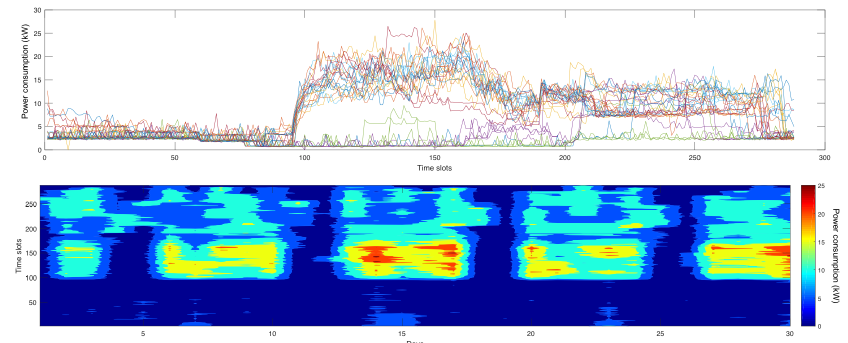
Figure 7. Pilot system: School (Palo del Colle). Power consumption seasonality.